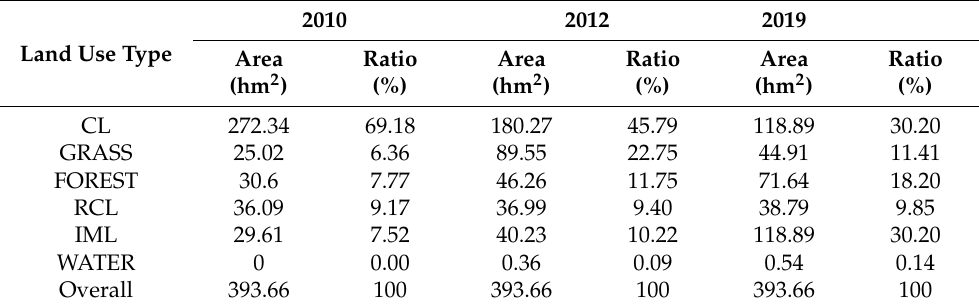
Figure 6. Land use pattern in the different periods: cultivated land (CL), grassland (GRASS), forestland (FOREST), rural construction land (RCL), industrial and mining area (IML), water (WATER). Table 4. Area and proportion of land use types in three coal mining life periods: cultivated land (CL), grassland (GRASS), forestland (FOREST), rural construction land (RCL), industrial and mining land